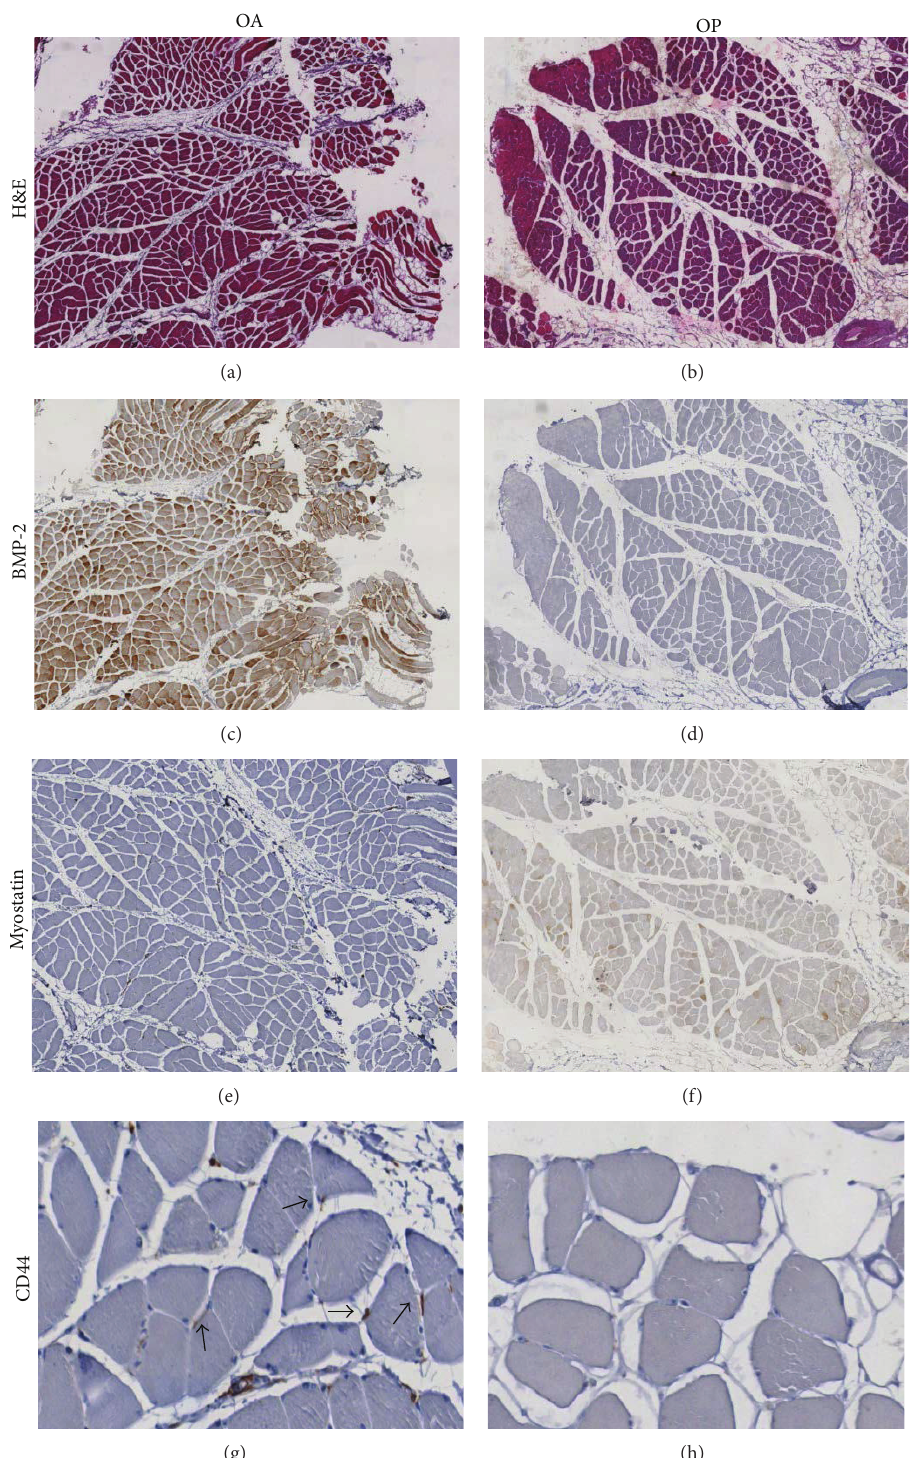
Figure 3: BMP-2 and satellite stem cells in muscle regenerations. ((a)-(b)) Hematoxylin and eosin sections of muscle biopsies showed a significant increase of fat tissue in OA (a) as compared to OP patients (b) (40x). (c) Image showed numerous BMP-2 positive fibers (40x). Often, in OP patients we did not observed BMP-2 expression (40x) (d). The Immunohistochemistry for myostatin was negative in OA muscle tissue (40x) (e). Muscle biopsies of OP group showed high/moderate expression of myostatin (40x) (f) inversely related to BMP-2 immunostain. Groups of satellite cells CD44 positive were focally dispersed in the tissue (200x) of OA patients (g) higher than that observed in OP patients (200x)